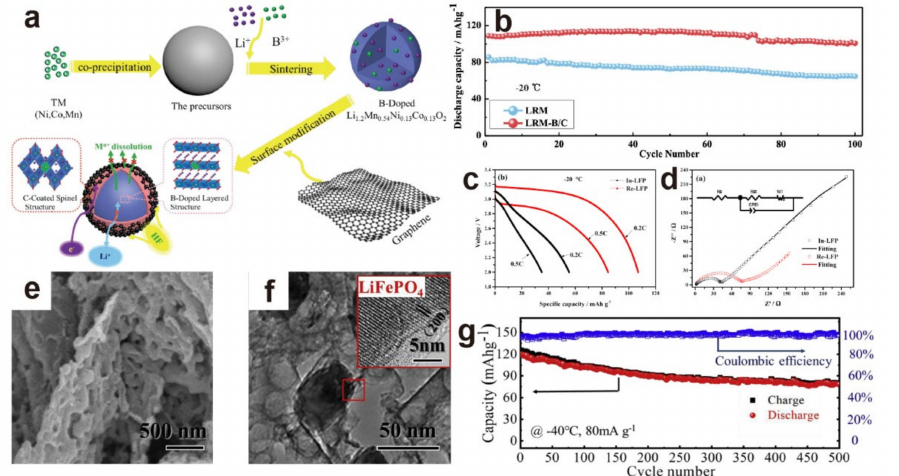
Figure 3. ( a ) Synthesis method and structure of the B-doped and carbon-modified Li 1.2 Mn 0.54 Ni 0.13 Co 0.13 O 2 ; ( b ) corresponding cycling performance at 1 C under − 20 ◦ C [60].